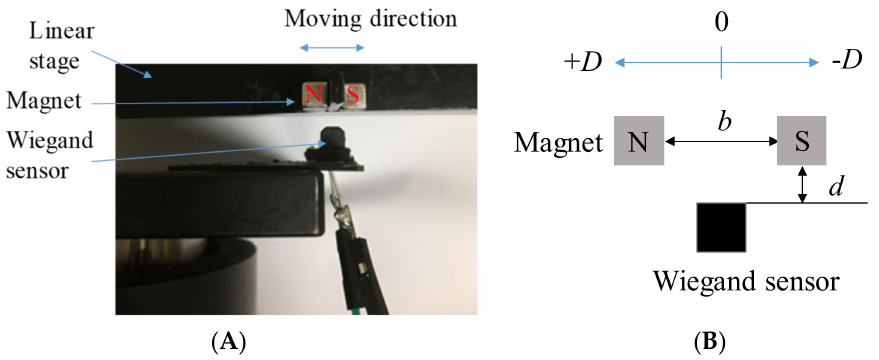
Figure 7. Using a linear stage to test Wiegand wires. ( A ) Experimental setup. ( B ) Parameter definitions.